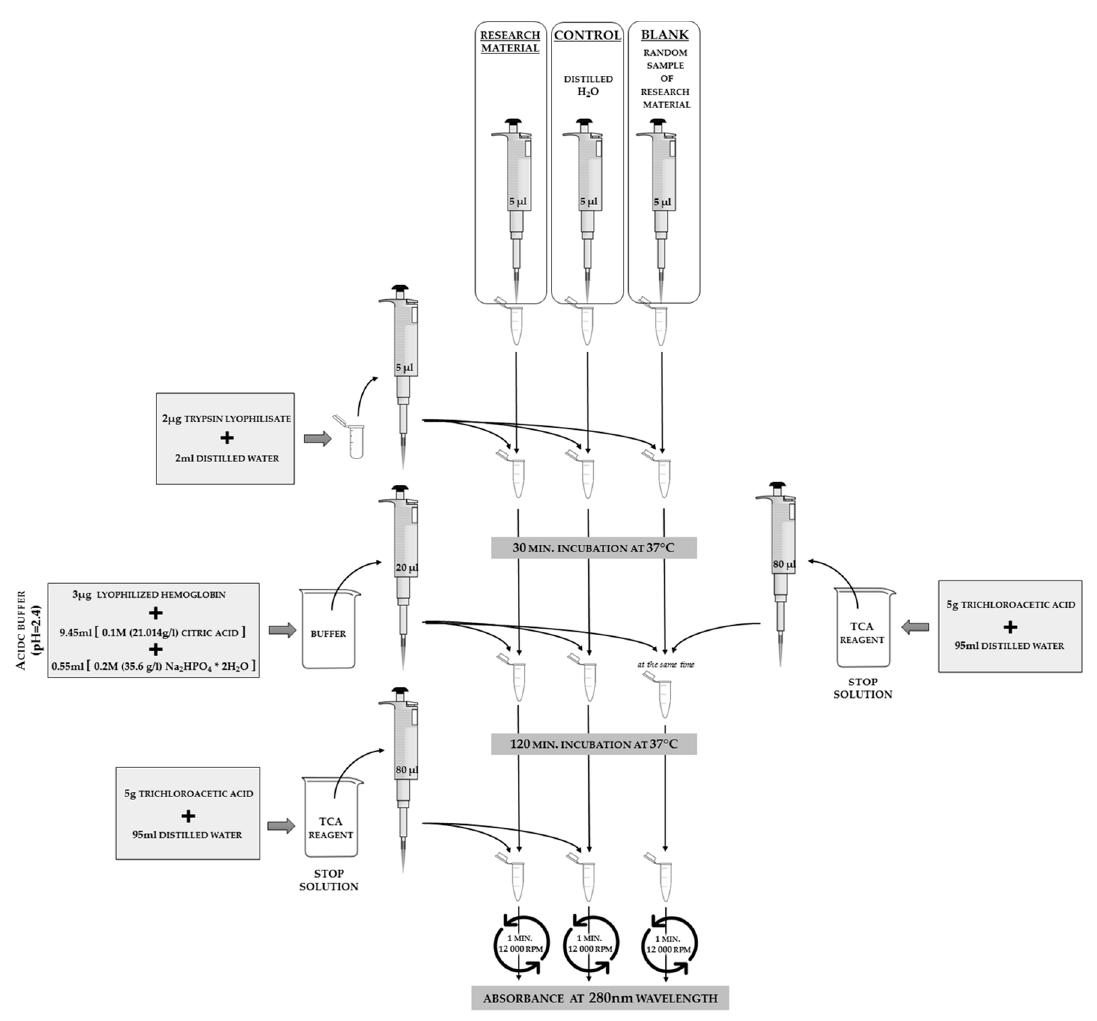
Figure 8. The scheme for acidic (2.4 pH) protease inhibitor activity analysis in hemolymph solutions or insect body surface elutions. In order to calculate the values of the protease inhibitor activities from the absorbance results, it is necessary to substitute the control sample absorbance in the calculation formula in order to determine the results when all the reagents are present but no reaction could occur because there was no biological material. It is also necessary to substitute the blank sample absorbance where the biological material was used, but no reaction occurred (the stop solution is added at the beginning of the procedure, as shown on the right part of the scheme). The phrase “random sample” refers to the case when we analyze a larger number of samples in one study; we may prepare only one control sample and only one blank for all of the samples that use the same set of reagents on the same day.